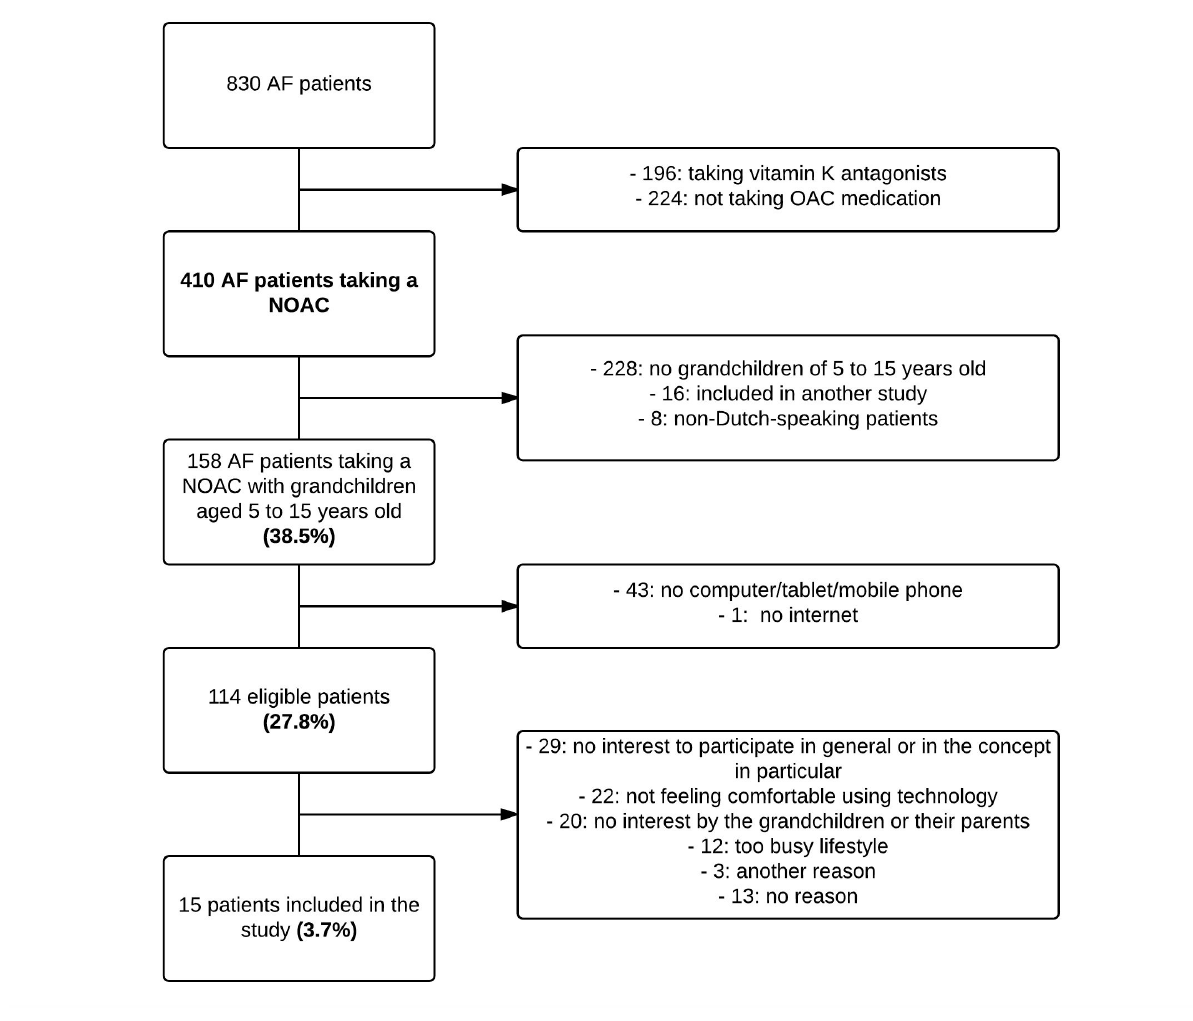
Figure 4. Flowchart of the different inclusion and exclusion criteria that resulted in 15 patients included (numbers between brackets refer to percentages of the 410 AF patients taking